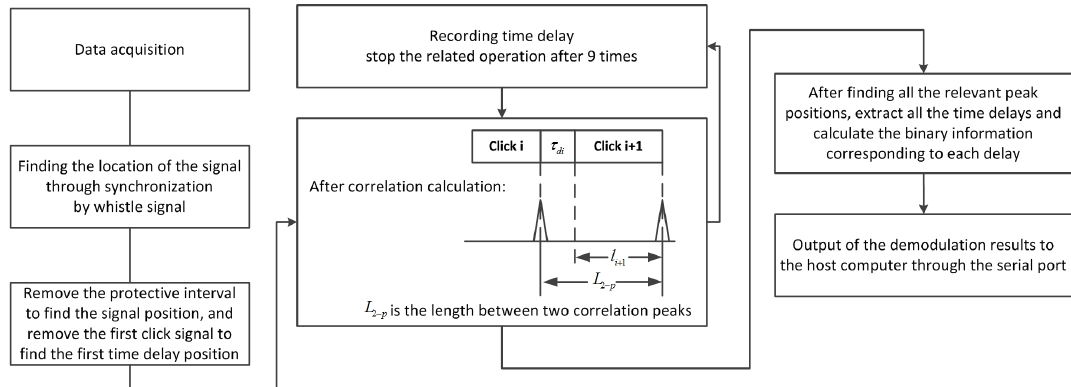
Figure 10. Process flow chart of bio-signal demodulation.